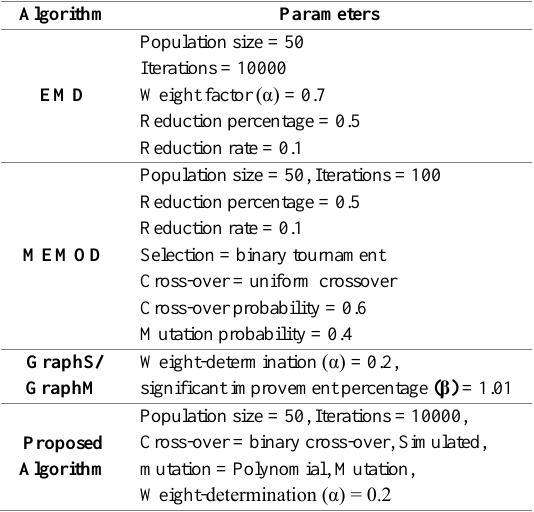
Table 3. Parameters of